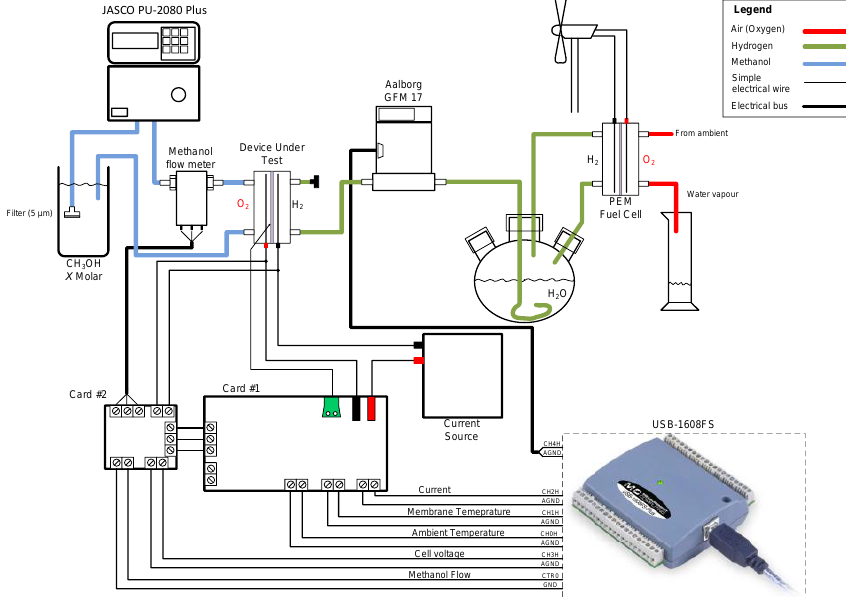
Figure 2. Diagram of experimental setup.